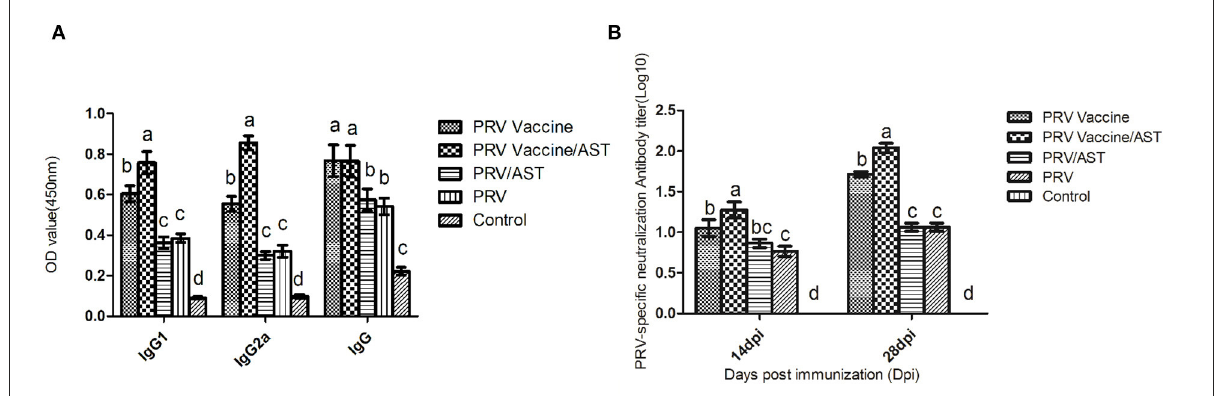
FIGURE1 Measurement of the IgG subclasses (A) and neutralizing antibody titers (B) in the serum at different days post-immunization. At 28 dpi, mice from each group ( n = 5) with different treatments were euthanized, and serum was collected for the detection of serum-specific IgG and isotypes by ELISA kits (A) . At 14 and 28 dpi, the serum was analyzed for PRV-specific neutralizing antibody titers (B) . Bars with different letters indicate significant differences ( p < 0.05).